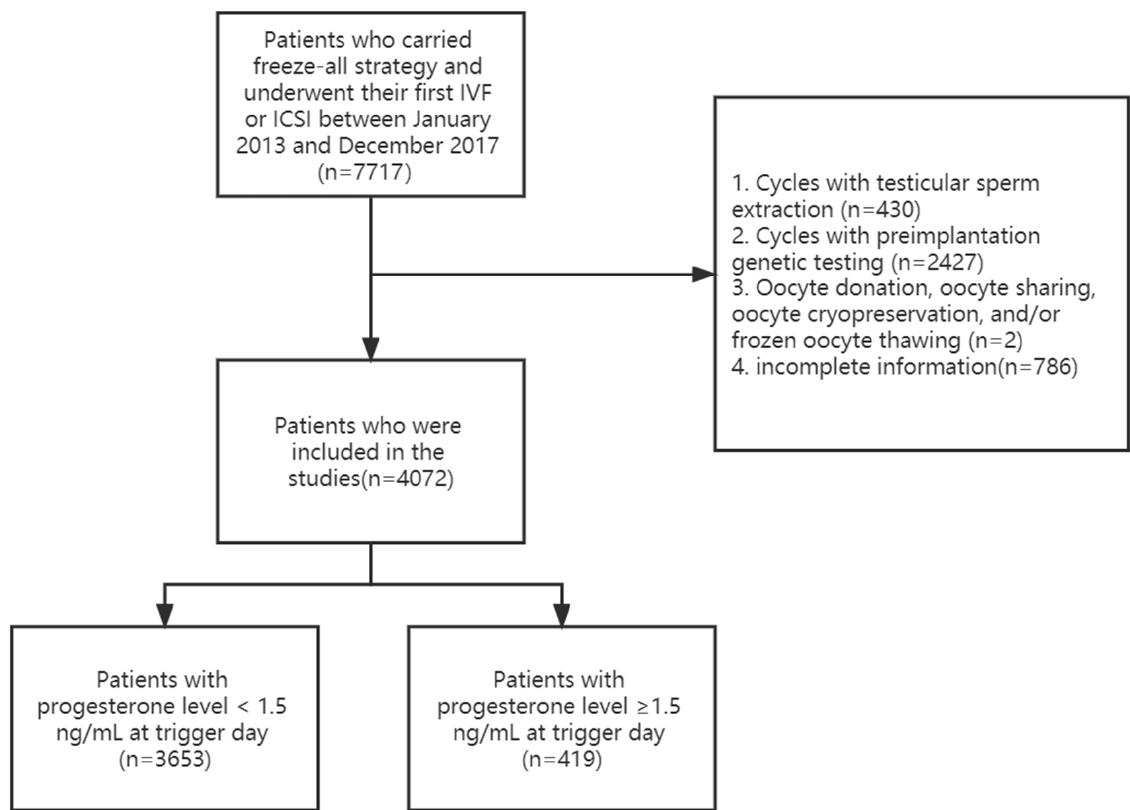
Figure 1. Flowchart showing the procedures used in selecting the studied